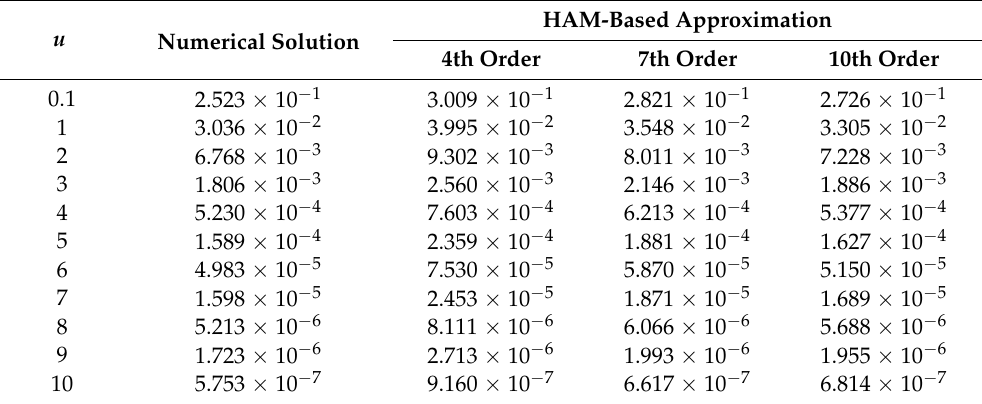
Table 2. Comparison between HAM-based approximation and numerical solution for the se- lected case.